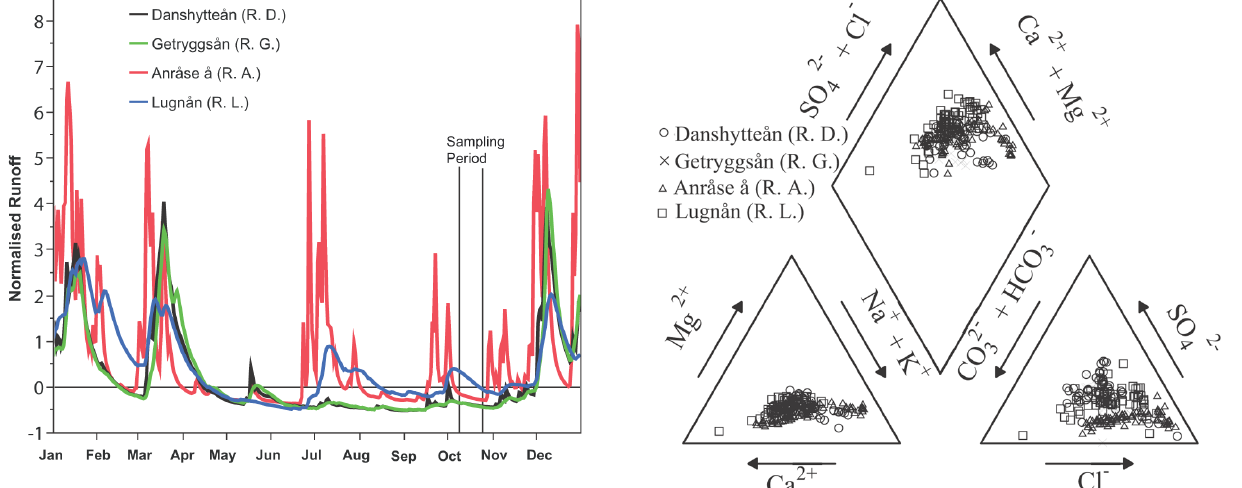
Fig. 2. Normalised daily HYPE modelled runoff ( Q ; see Methods section for details) for 2007, where River Anr˚ase ˚a is represented by the red line, River Lugn˚an by the blue line, River Danshytte˚an by the black line and River Getryggs˚an by the green line. The vertical solid lines indicate the sampling period for all rivers in October 2007. The sampling took a maximum of three days per river; see Table 1 for exact dates and to get modelled runoff in m 3 s − 1 .